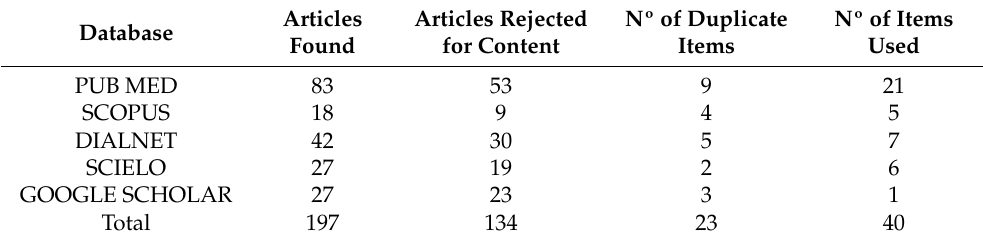
Table 1. Summary of Databases and Papers Reviewed.